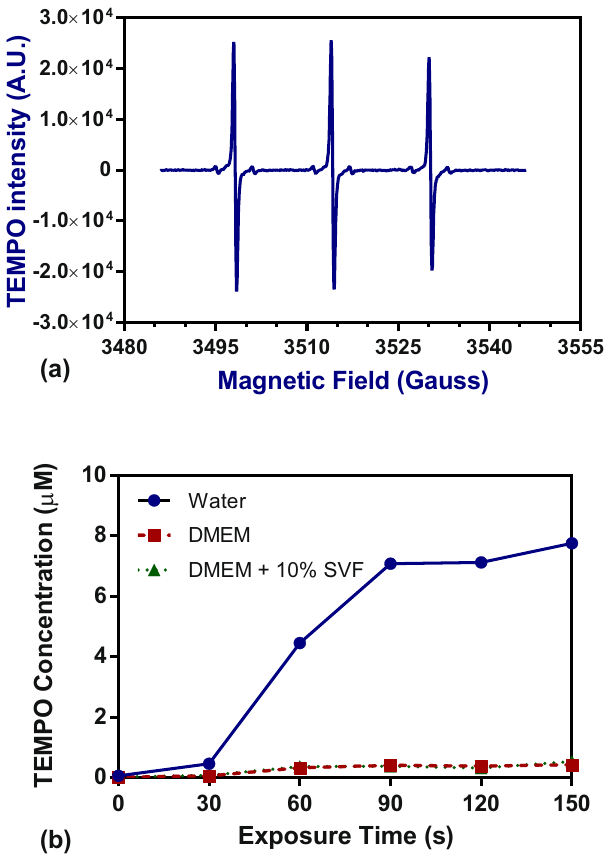
Figure 5. ( a ) TEMPO EPR spectrum obtained after 150 s of plasma treatment in Milli-Q water. ( b ) Evolution of TEMPO signal in three media as a function of plasma jet exposure. Half height of the first peak was chosen to represent TEMPO